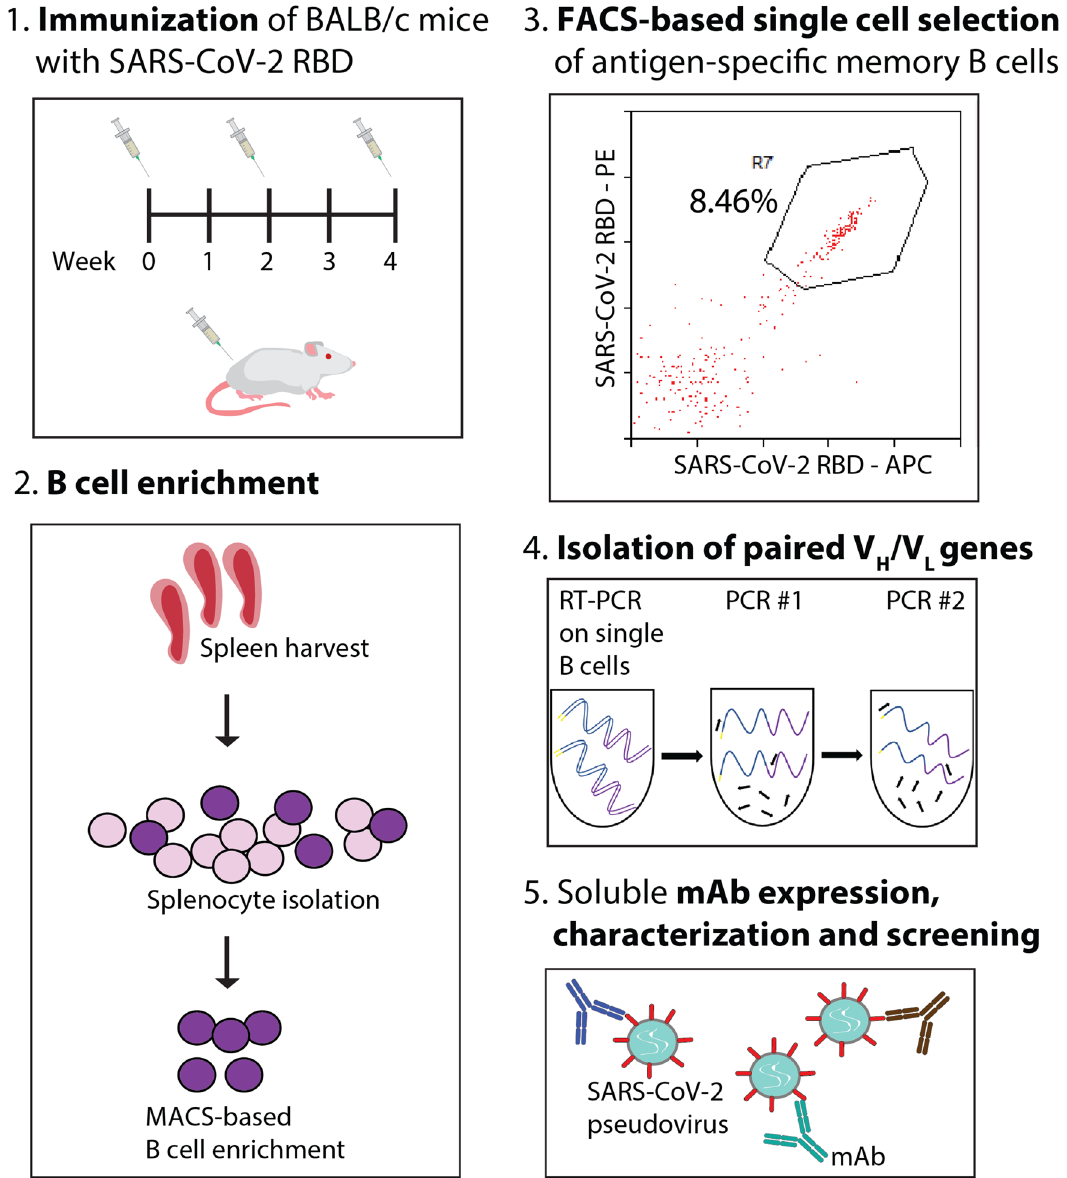
Figure 1. Overview of methodologies for discovery and characterization of potent SARS-CoV-2 neutralizing antibodies isolated from single B cells. ( 1 ) BALB/c mice were immunized with SARS-CoV-2 RBD three times at 2-week intervals. ( 2 ) Splenocytes were harvested six weeks following the initial vaccination from which B cells were isolated via MACS and labeled for cell sorting. ( 3 ) Cells positive for binding to SARS-CoV-2 RBD labeled with two unique fluorophores (gate R7) were sorted as single cells into 96-well plates. ( 4 ) Multiple PCR steps were employed to isolate V H and V L antibody genes. ( 5 ) Antibodies were expressed, purified, and evaluated for antigen binding, neutralizing activity, and biophysical